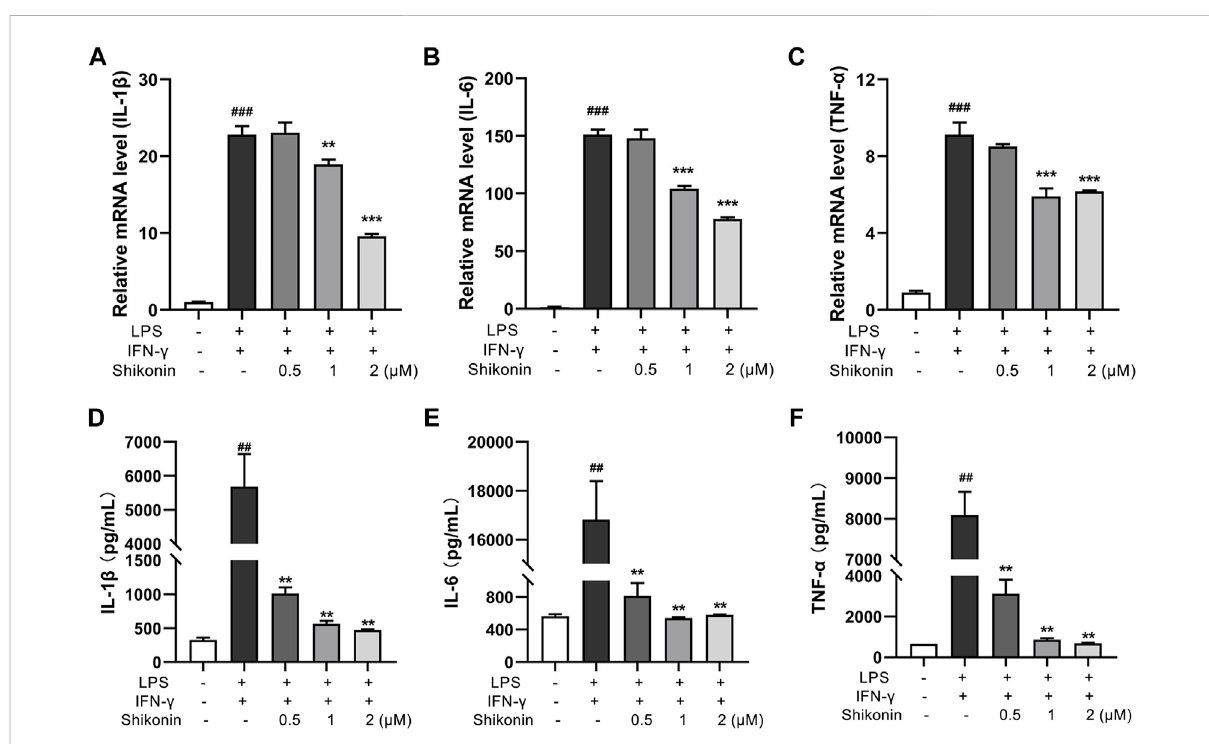
FIGURE 5 Shikonin inhibited proin fl ammatory cytokines in RAW264.7 cells. Relative mRNA expression of IL-1 β (A) , IL-6 (B) , TNF- α (C) in RAW264.7 cells were evaluated by RT-qPCR. The levels of IL-1 β (D) , IL-6 (E) and TNF- α (F) in RAW264.7 cells were determined by ELISA. Data are shown as the mean ± SD, n = 3. ## p < 0.01, ### p < 0.001, compared to the control group. ** p < 0.01, *** p < 0.001, compared to the LPS + IFN- γ